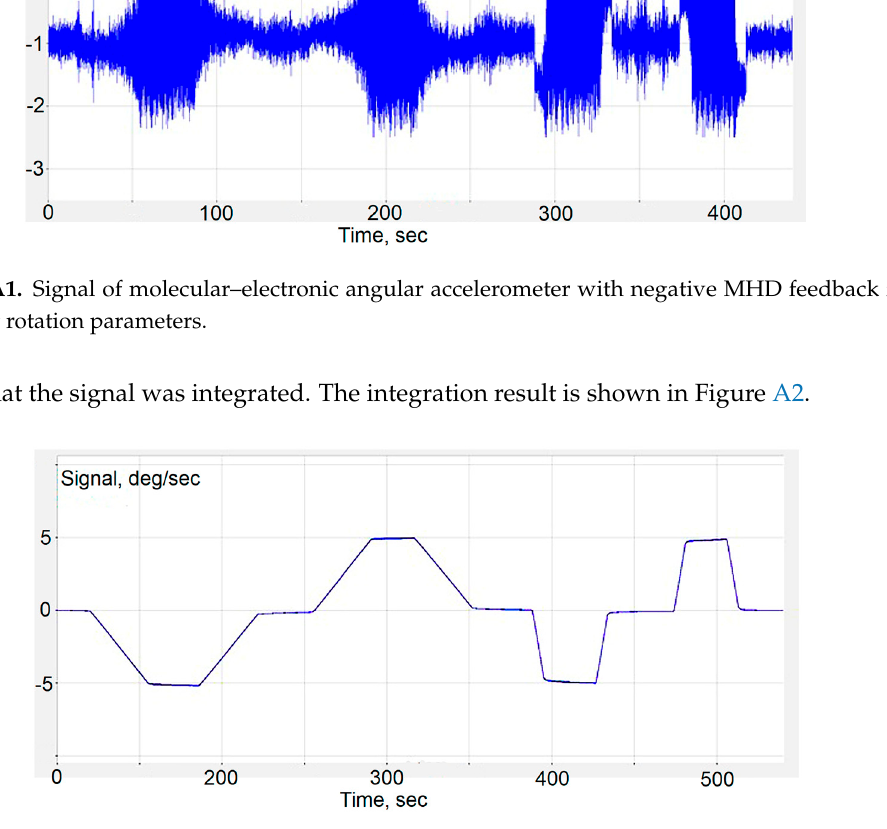
Figure A2. Accelerometer-integrated signal.